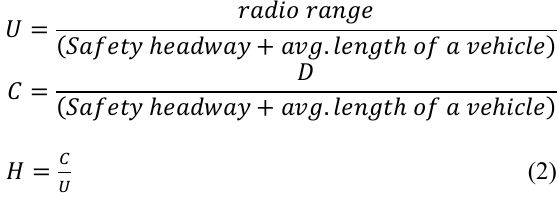
Retrieve the neighbors’ information from neighbor information table